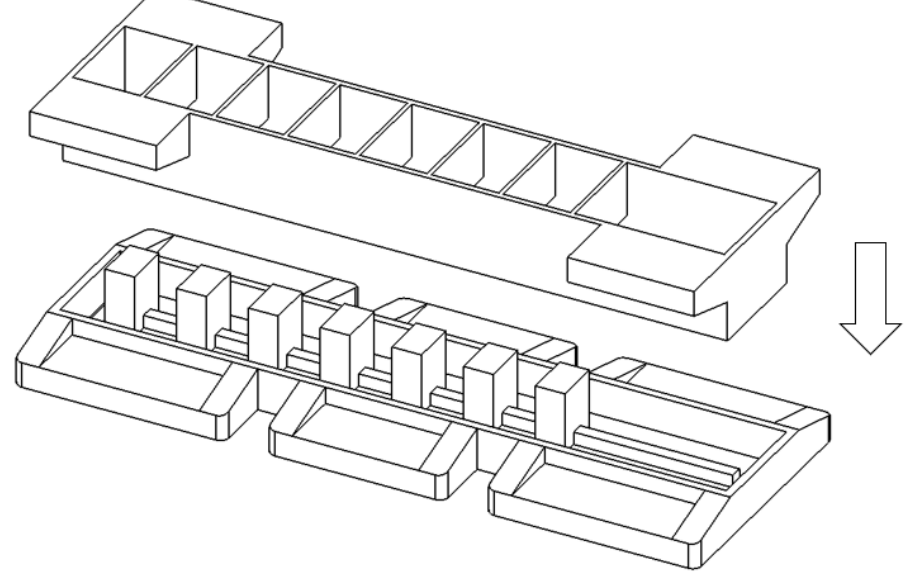
Figure 4. Two-Piece Mold for Soft Actuator Component